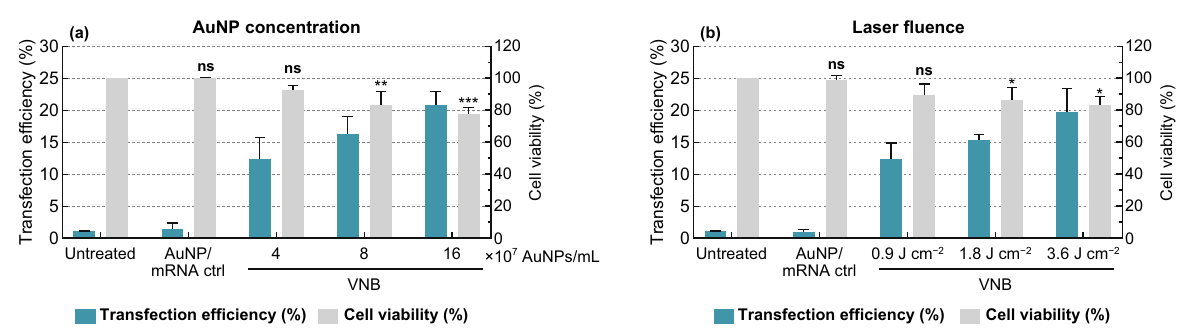
Fig. 2 Optimization of gold nanoparticle (AuNP) concentration and laser fluence for eGFP-mRNA transfection in HeLa cells. a HeLa cells were photoporated in the presence of 0.3 µM eGFP-mRNA with increasing AuNP concentrations using a fixed laser fluence of 1.8 J cm −2 . b HeLa cells were photoporated in the presence of 0.3 µM eGFP-mRNA with increasing laser fluences using a fixed AuNP concentration of 8 × 10 7 AuNPs mL − . Transfection efficiencies are expressed as the percentage eGFP-positive cells as determined by flow cytometry ( n ≥ 3). Cell viabil- ity values were determined with the CellTiter-Glo assay and expressed relatively to the untreated control ( n = 3). One-way ANOVAs with Dun- nett’s multiple comparison test were performed to determine statistical differences ( ns = nonsignificant; * p < .05; ** p < .01; *** p <